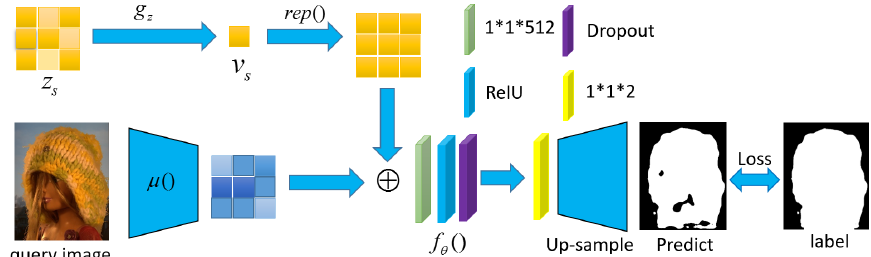
Figure 6. The model structure of the segmentation branch, where the convolution component f θ consists of the convolution layer, activation layer and Dropout, which is used to compute the distance between pixels from support to query. Where the z s represents the guidance, g z represents global pooling and v s represents the pooled guidance